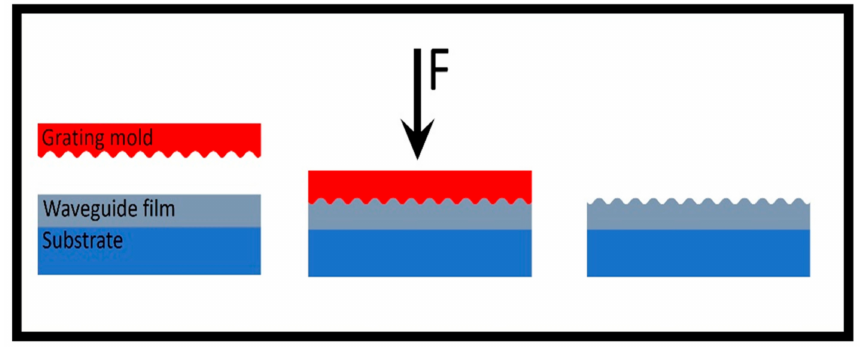
Figure 7. Schematic representation of VGC sensor fabrication by direct imprinting on WG